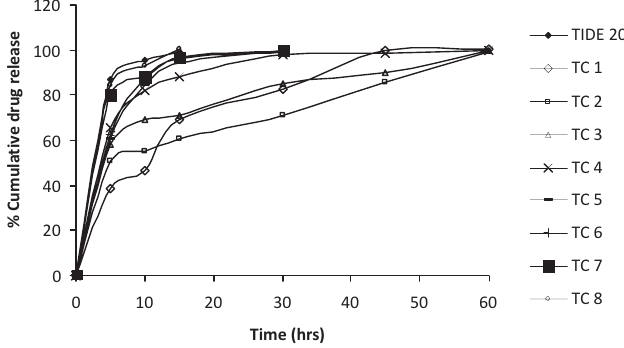
TABLE VI - Evaluation of physico-chemical parameters of Compression coated tablets of PEO WSR 1105 Hardness Formulations (kg/cm 2 )